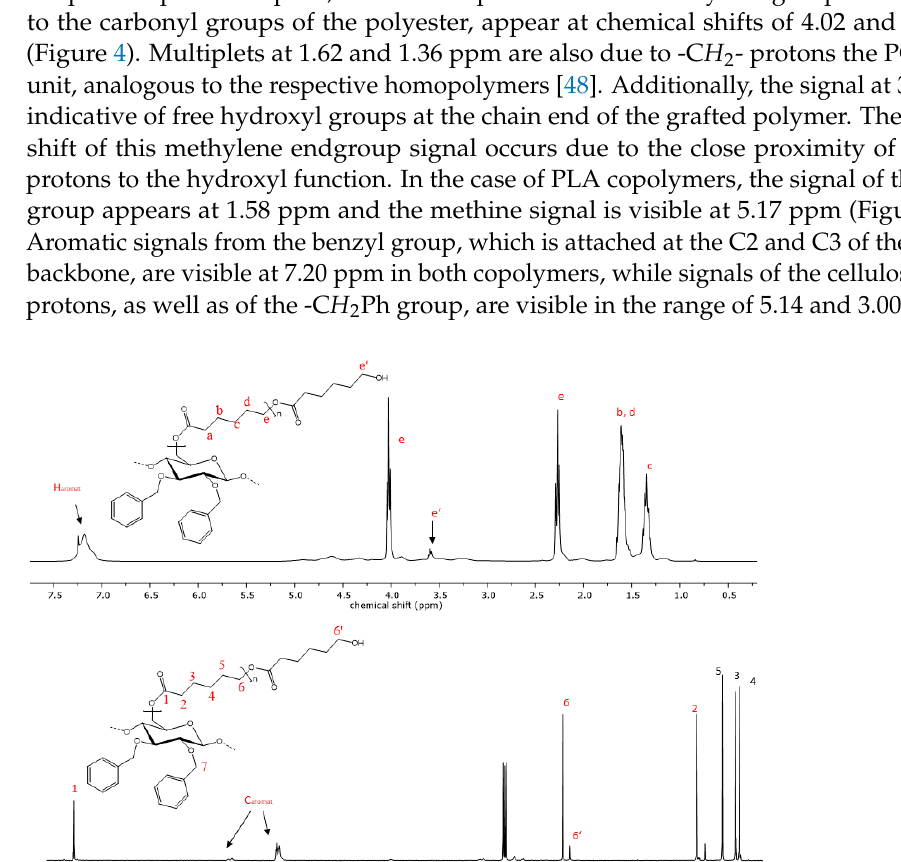
Figure 3. FTIR spectra of cellulose-based copolymers with poly( ε -caprolactone) (9–11) or poly(L-lactide) (12–14) sidechains.